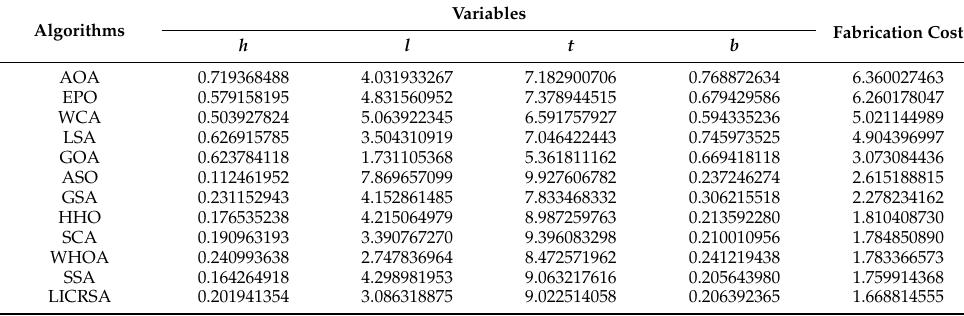
Table 7. Numerical results for the welded beam design